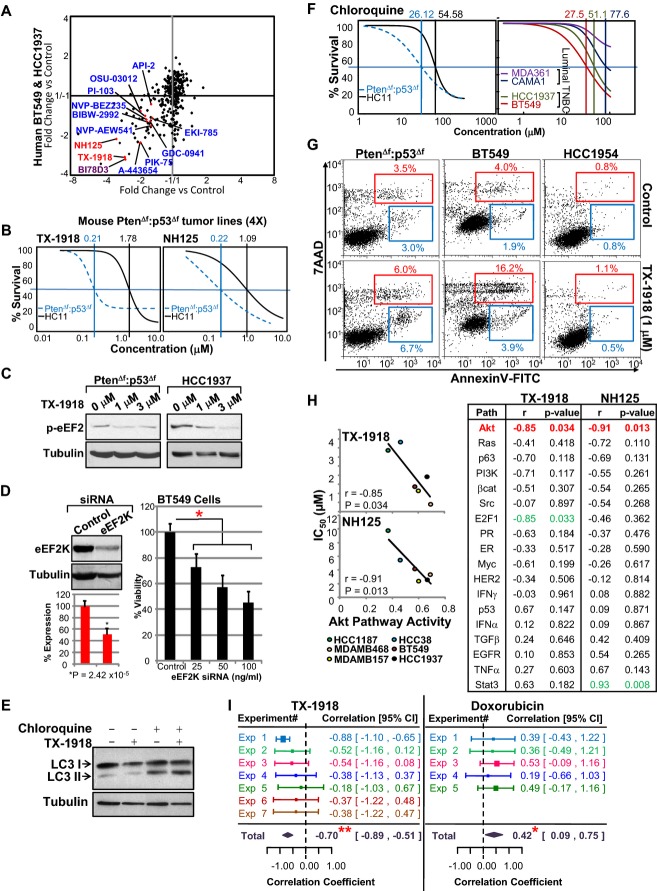
Kinome drug screen identifies eEF2K inhibitors as potential therapeutic targets for TNBC with
elevated AKT signalingKinase inhibitor screens on four independent primary
MMTV-Cre:Ptenf/f:p53f/f tumor lines and two human Pten/p53 mutant BT549 and
HCC1937 TNBC cell lines. Inhibitors for eEF2K (red), JNK (purple) and PI3K/AKT/mTOR (blue) are
highlighted.Dose–response curves for mouse MMTV-Cre:Ptenf/f:p53f/f tumors versus
immortalized HC11 epithelial cells treated with indicated eEF2K inhibitors.Inhibition of eEF2 phosphorylation by eEF2K inhibitor, TX-1918. Mouse or human Pten/p53-deficient
tumor cells were serum-starved for 2 h, treated for 1 h with indicated concentrations
of TX-1918 and immunoblotted with anti-Thr56 eEF2 antibody. Tubulin served as a loading control.BT549 cells were transfected with control (Dharmacon) or eEF2K siRNA at 25, 50 or
100 ng/ml. Two days later, cells were analyzed for eEF2K expression by Western blotting and
for growth by MTT assay. *Significant difference comparing siRNA at 25 ng/ml with
control, P = 0.00479 by ANOVA with Tukey test for post
hoc. Comparisons at other concentrations gave lower P-values.Chloroquine but not TX-1918 suppresses autophagy/LC3-II accumulation.Dose–response curves for mouse MMTV-Cre:Ptenf/f:p53f/f tumor versus
immortalized mouse epithelial HC11 cells and human TNBC (BT549, HCC1937) versus luminal (MDA361,
CAMA1) cells treated with chloroquine.Levels of apoptosis in mouse PtenΔf:p53Δf, human BT549 and
HER2+ HCC1954 cells after TX-1918 treatment as determined by Annexin V and 7AAD
flow cytometry.Correlation analysis demonstrating that high AKT pathway activity but not 17 other signaling
pathways sensitizes TNBC cells to eEF2K inhibitors TX-1918 and NH125.Meta-analysis demonstrating that high AKT pathway activity sensitizes TNBC cells to eEF2K
inhibition (TX-1918). IC50 values for TX-1918
(n = 7) and control doxorubicin
(n = 5) were determined in human TNBC cell lines (HCC38,
HCC1937, BT549, MDAMB157, MDAMB436, MDAMB468). Correlation coefficient (r) of
IC50 values with AKT pathway activities was calculated for each experiment by linear
regression using meta-analysis, metaphor package in r:
**r = −0.70,
P < 0.0001 for TX-1918;
*r = 0.42,
P < 0.02 for doxorubicin.